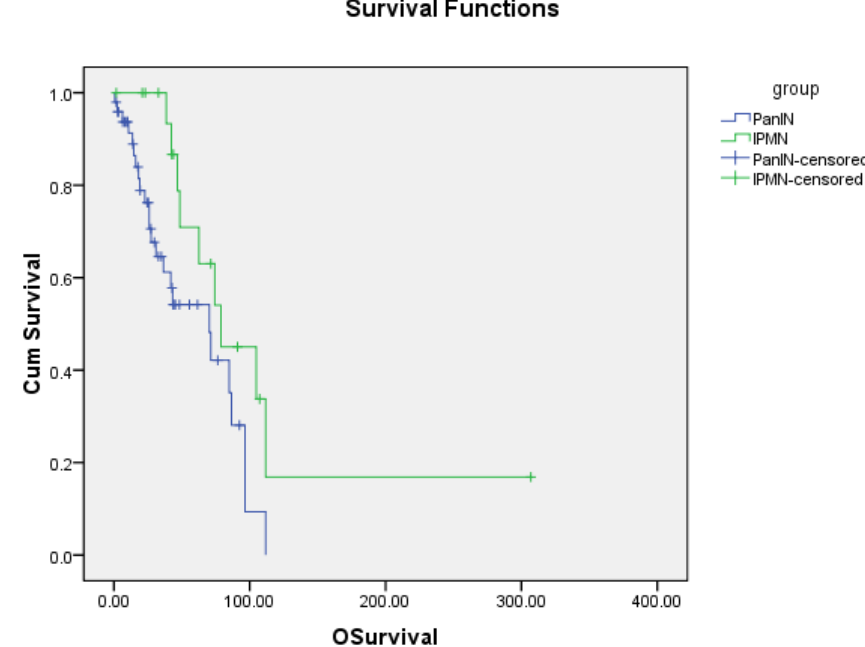
Figure 1. Overall survival of PanIN and IPMN. Osurvival—overall survival; Cum Survival— cumulative survival; PanIN—Pancreatic Intraepithelial Neoplasia; IPMN—Intraductal Papillary Mucinous Neoplasia.